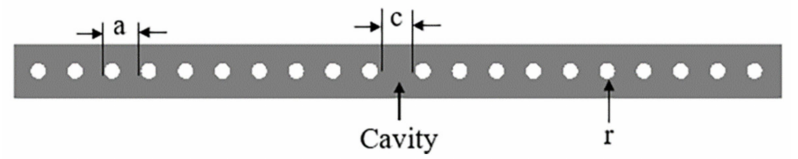
Figure 1. The structure of one-dimensional photonic crystal (1D PhC) and its geometrical